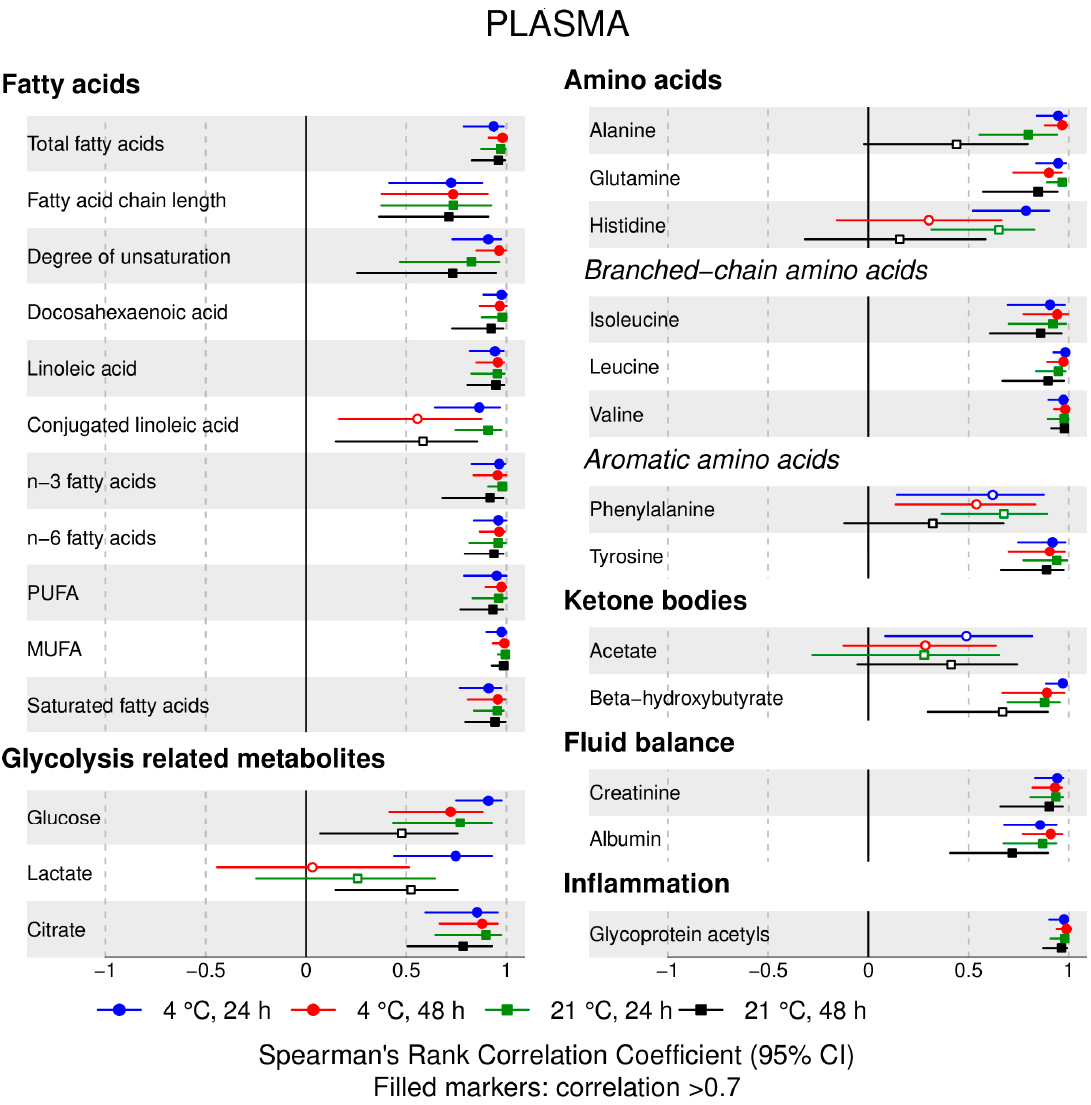
Figure 4. EDTA-plasma, pre-storage handling effects (Figure 3 continued): Spearman’s rank correlation coefficients between metabolic trait concentration/value in reference samples (4 °C, 1.5h) and samples incubated at (i) 4 °C, 24 h; (ii) 4 °C, 48 h; (iii) 21 °C, 24 h; and (iv) 21 °C, 48 h, before